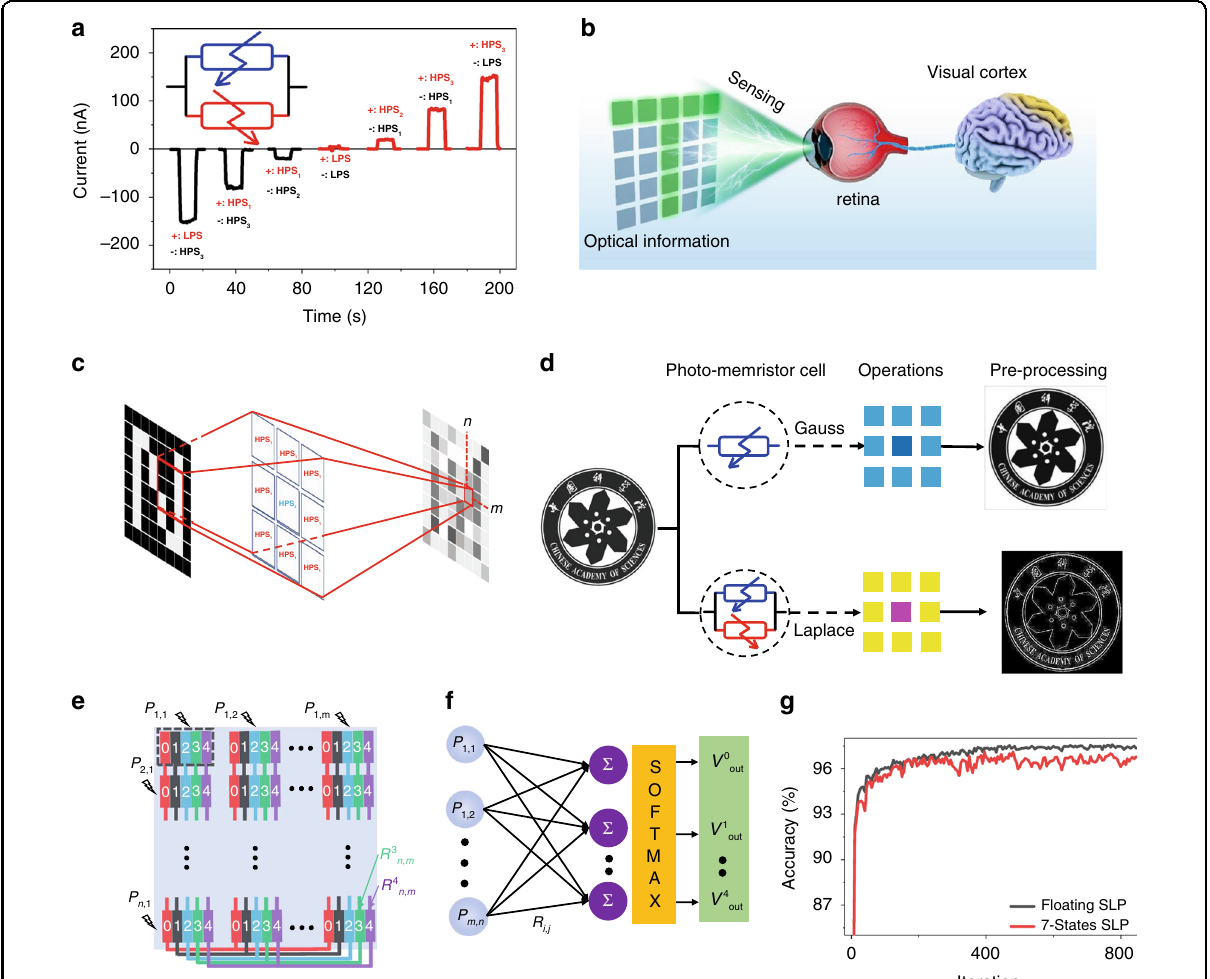
Fig. 4 Image pre-processing and classi fi er based on G/M/G devices. a Photocurrent for different photoresponse states, in a different set of photomemristors. The inset shows schematically photomemristors installed with opposite polarity. b Schematic representation of the human visual system for sensing, memory, and computing. c Photomemristors with integrated sensing-memory-computing architecture. d Demonstration of image processing with various operators. These operations are realized by varying the different states and polarities of the photomemristors. e Schematic Illustration of the SLP photomemristors array for classi fi er emulation, all photomemristors with the same class (color) are connected in parallel to obtain the output current for the activation function. f SLP neural network architecture schematics. g Accuracy of the SLP classi fi er during training with fl oating-point weight and discrepant 7-level photoresponse